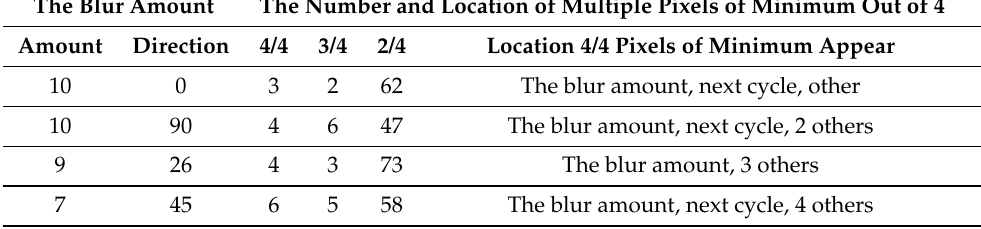
Table 10. The number of the pixels and their locations where multiple pixels of minimum appeared out of four sub-images out of area